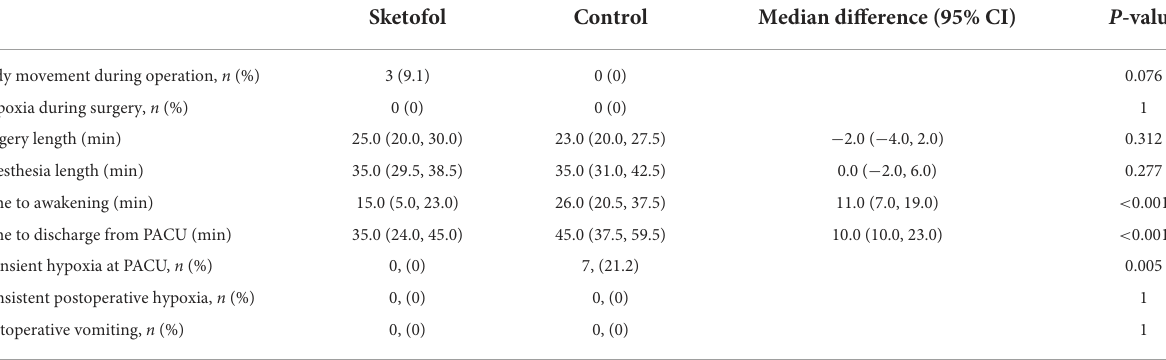
TABLE 5 Secondary outcomes: body movement during operation, hypoxia during surgery, surgery length, anesthesia length, time to awakening, time to discharge from PACU, postoperative vomiting and postoperative hypoxia. Sketofol Control Median difference (95% CI) P